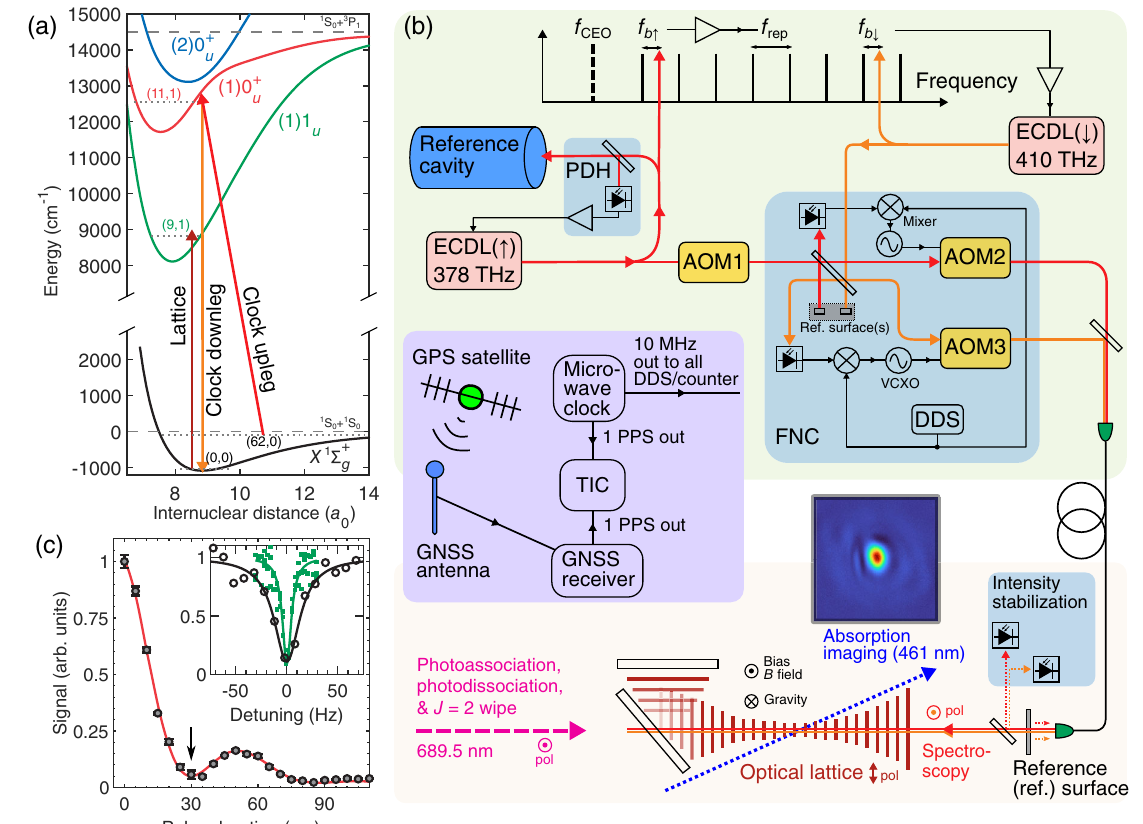
FIG. 1. Vibrational molecular lattice clock. (a) Raman lasers (upleg, red arrow; downleg, orange arrow) detuned from an intermediate state in ð 1 Þ 0 þ probe the two-photon vibrational clock transition between ð v ¼ 62 ; J ¼ 0 Þ and ð v ¼ 0 ; J ¼ 0 Þ in the X 1 Σ þ u potential. The optical lattice (brown arrow) off-resonantly addresses an isolated rovibronic state in ð 1 Þ 1 conditions. (b) Experimental setup. The upleg master laser is stabilized to a reference cavity using the Pound-Drever-Hall (PDH) technique, and its phase coherence is transferred to the downleg laser via a frequency comb. The molecules are held in the 1D optical lattice. Copropagating clock lasers are delivered to the molecules via an optical fiber with active fiber noise cancellation (FNC). The spectroscopic signal derives from absorption imaging of X ð 62 ; 0 Þ photofragments at a slight grazing angle relative to the lattice. A Rb microwave standard acts as a flywheel oscillator linking the molecular clock to GPS time for the absolute frequency measurement. Further information is given in the main text and Appendices A and B. (c) Two-photon Rabi oscillations between the clock states driven at the operational probe intensities (filled circles, experimental data averaged over eight consecutive runs, error bars represent 1 σ uncertainties; solid red line, analytical fit to an exponentially decaying sinusoid). We observe lines as narrow as 11(1) Hz (inset, green squares). For clock operation, we perform Rabi spectroscopy with a 30-ms π -pulse duration (indicated by the black arrow), resolving 30(2)-Hz linewidths consistent with the expected Fourier limit (inset, black open circles). Each point in the inset is a single shot of the experiment, and solid lines are Lorentzian